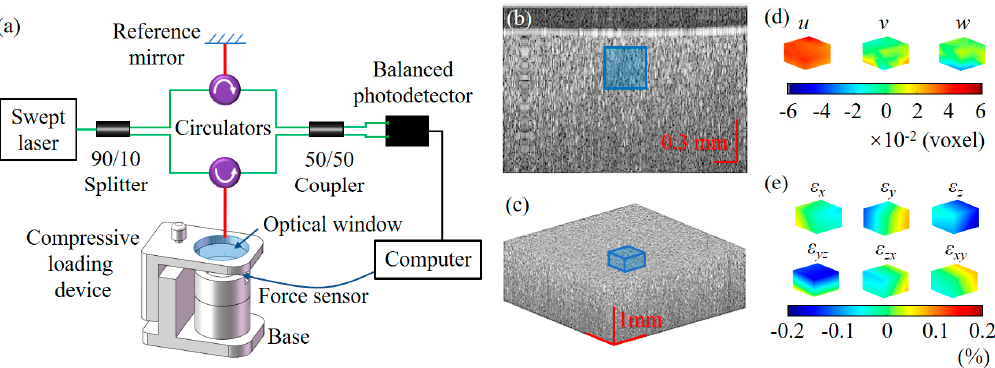
Figure 1. The SSOCT and compressive loading system. ( a ) A schematic diagram of the system; ( b ) a 2D OCT cross-sectional image (B-scan); ( c ) a 3D volumetric OCT image. Stationary experiment: ( d ) 3D displacements in the x , y and z directions of the ROI; ( e ) 3D strain tensors of the ROI. The ROI is marked out with a blue rectangle in ( b ) and with a blue cube in ( c ).